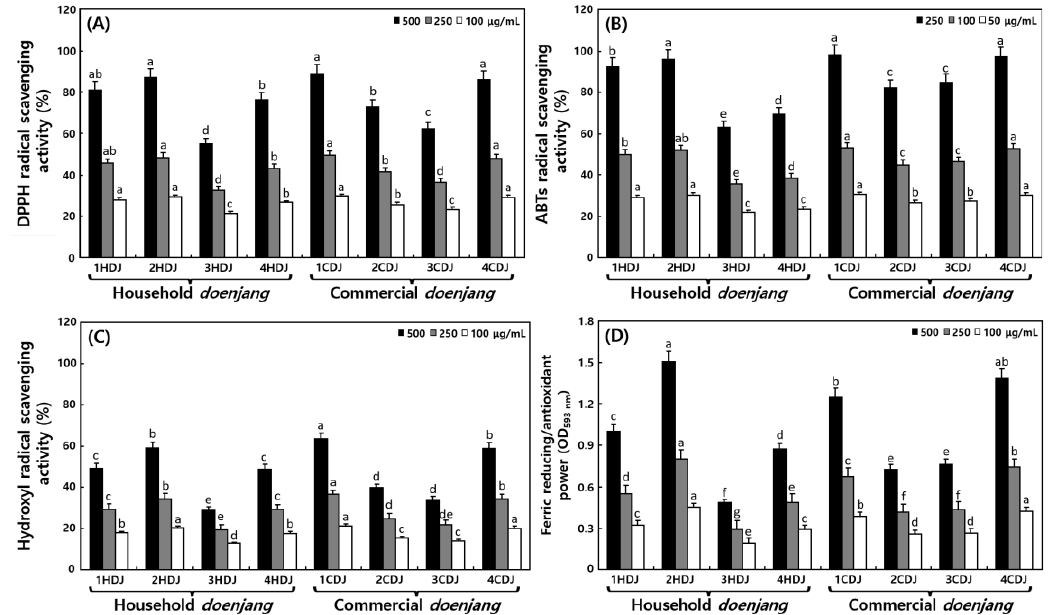
Figure 6. Comparisons of antioxidant activities of 50% MeOH extracts from household and com- mercial doenjang . ( A ) DPPH radical scavenging activity; ( B ) ABTS radical scavenging activity; ( C ) hydroxyl radical scavenging activity; and ( D ) ferric reducing/antioxidant power. All values are means of determination from three independent experiments. Different letters above the bars indicate significant difference at p < 0.05.